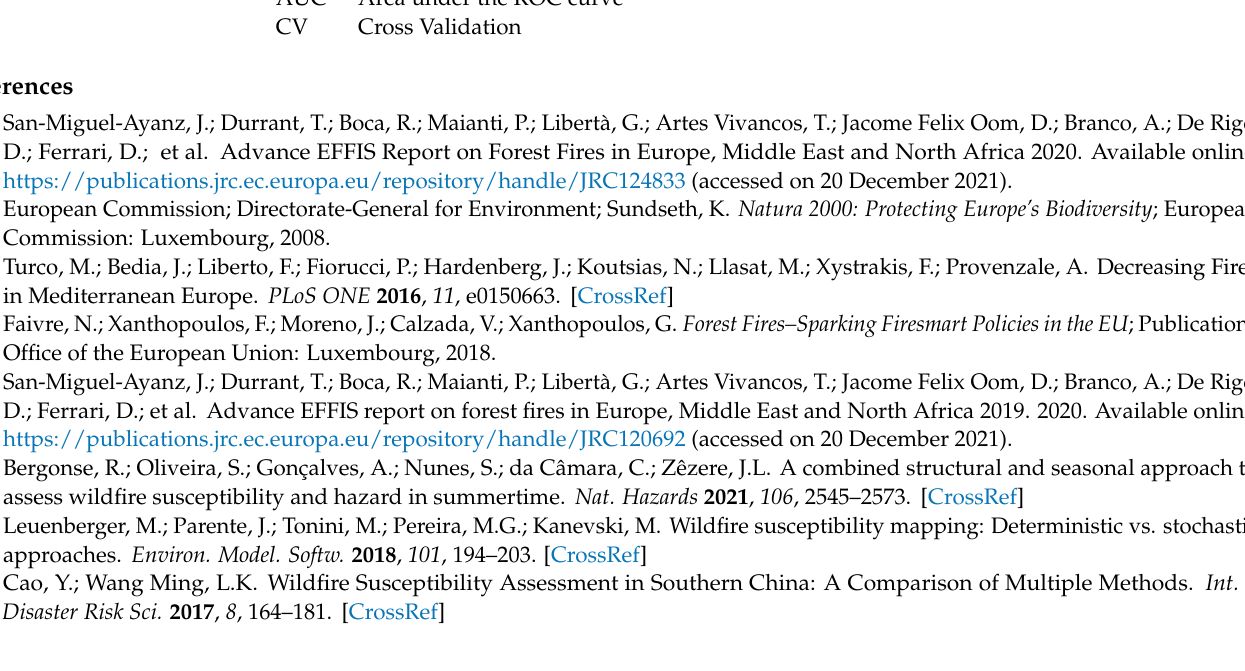
Figure S9: Normalized susceptibility distribution inside the Sclerophyllous vegetation in the summer season (class 323). Figure S10: Normalized susceptibility distribution inside the non-irrigated arable land in the winter season (class 211). Figure S11: Normalized susceptibility distribution inside the rice fields in the winter season (class 242). Figure S12: Normalized susceptibility distribution inside the broad leaved in the winter season (class 311). Figure S13: Normalized susceptibility distribution inside the Transitional woodland in the winter season (class 211). Figure S14: The two histograms refer to the susceptibility distribution in the 2 wildfires presented in Figure 19: the Montiferru wildfire on the left hand side, and the Marghine wildfire on the right hand side. The susceptibility map presents values over 0.5 in almost the totality of the pixel affected by the two wildfires, with a good of values over 0.7. Figure S15. The two histograms refer to the susceptibility distribution in the two considered wildfires. The histogram on the left hand side refers to Montiferru wildfire, while the one on the right hand side to the Marghine wildfire. In both cases, most of the pixels fall on the two highest susceptibility classes. Table S1: CLC Codes and their description. The class evidenced by the ( ∗ ) symbol have not been used as input data of the machine learning model. For technical purposes, they have been merged into an ad hoc class